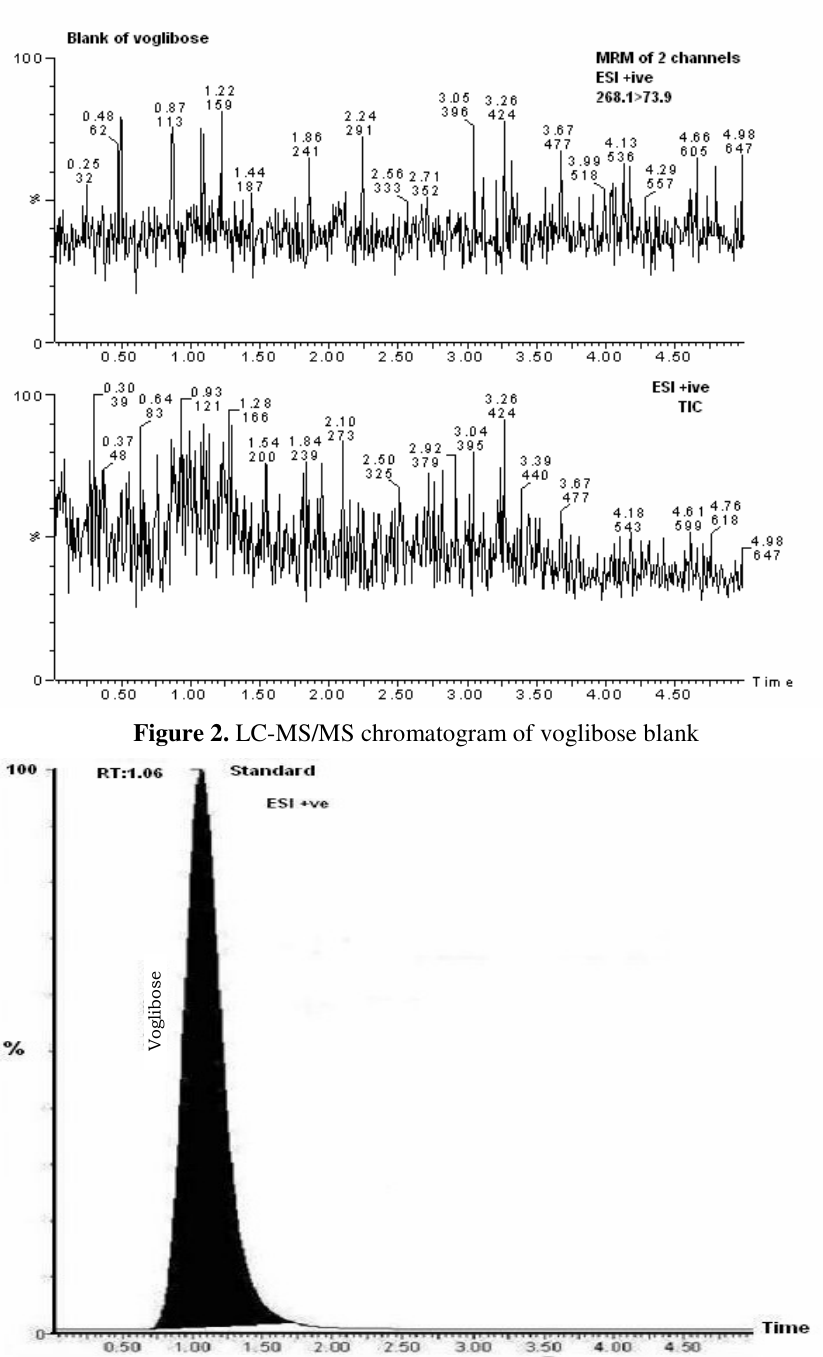
Figure 3. LC-MS/MS chromatogram of standard